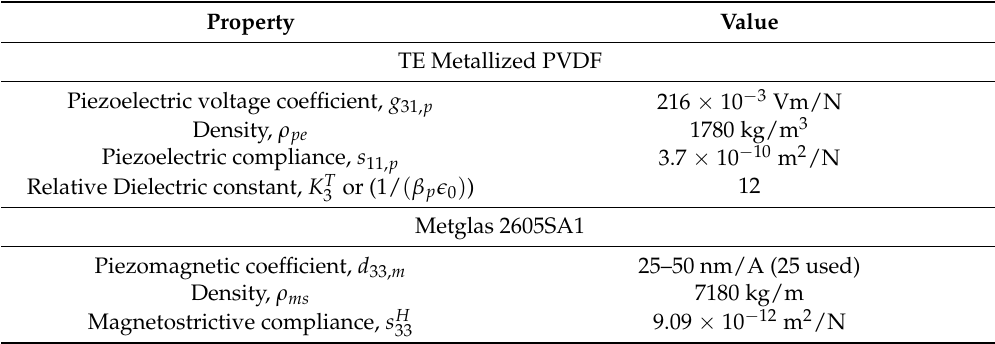
Table 4. Material properties used for Metglas-PVDF model [25,29].